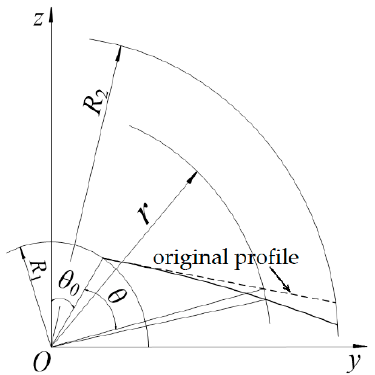
Figure 4. Schematic diagram of the blade profile while it is controlled by Taylor polynomial.